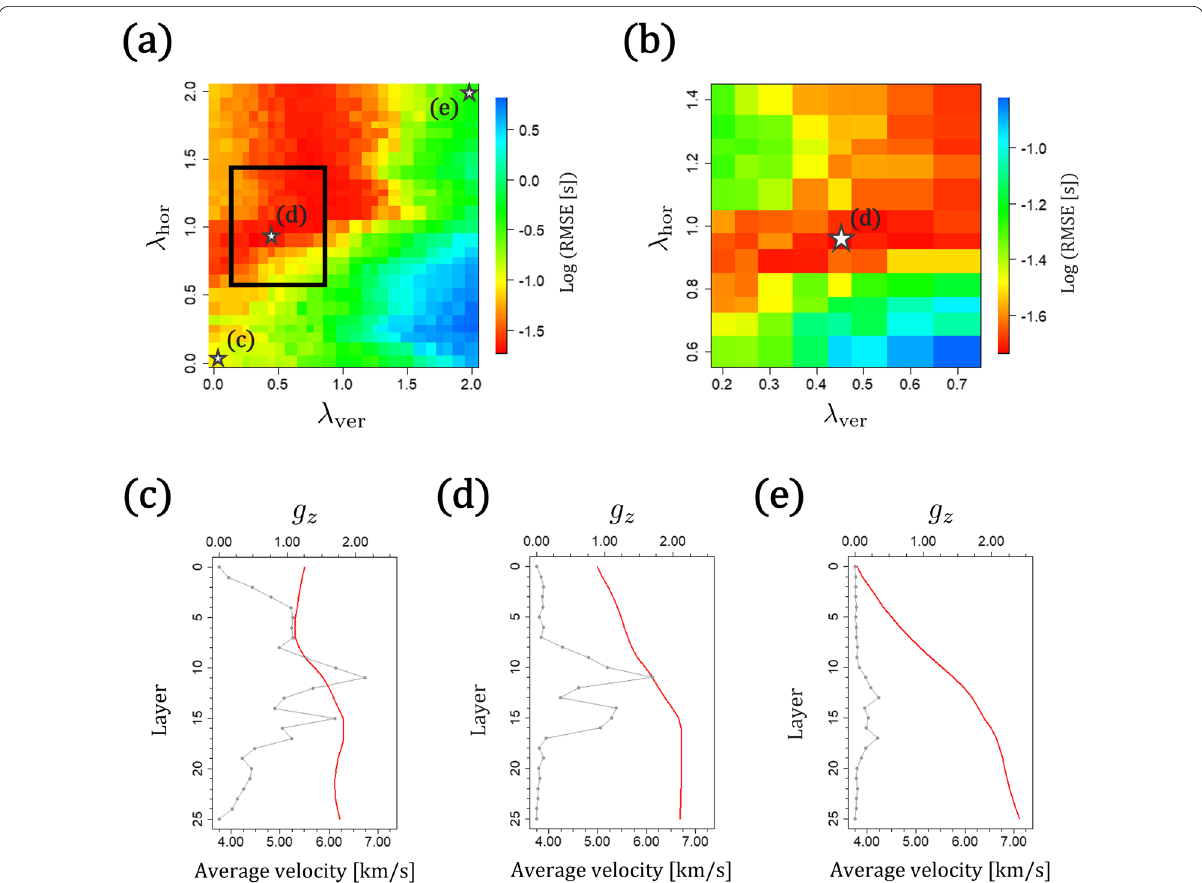
Fig. 11 a Heat map of RMSE value for each pair of regularization parameters ( (cid:31) ver , (cid:31) hor ) , in logarithmic scale. b Magnified view of around optimal point, (0.45, 0.95), illustrated by star. The drawing range is shown in a by the rectangle. c – e Estimated average velocities of each layer (red) and g z values (grey) for three pairs of regularization parameters: c (0.10, 0.10), d (0.45, 0.95), and e (2.00, 2.00). The corresponding points are shown in a by the